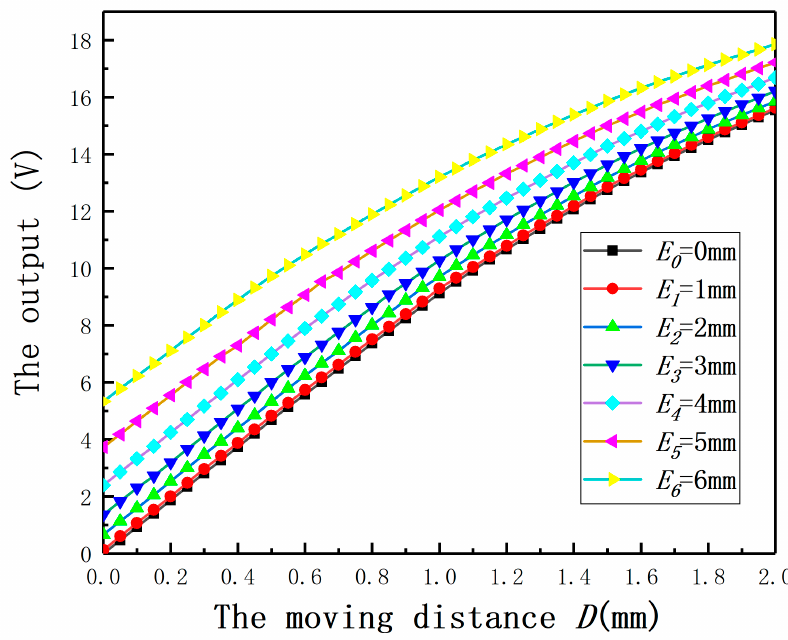
Figure 15. The relationship between the output and the moving distance under different eccentricities.